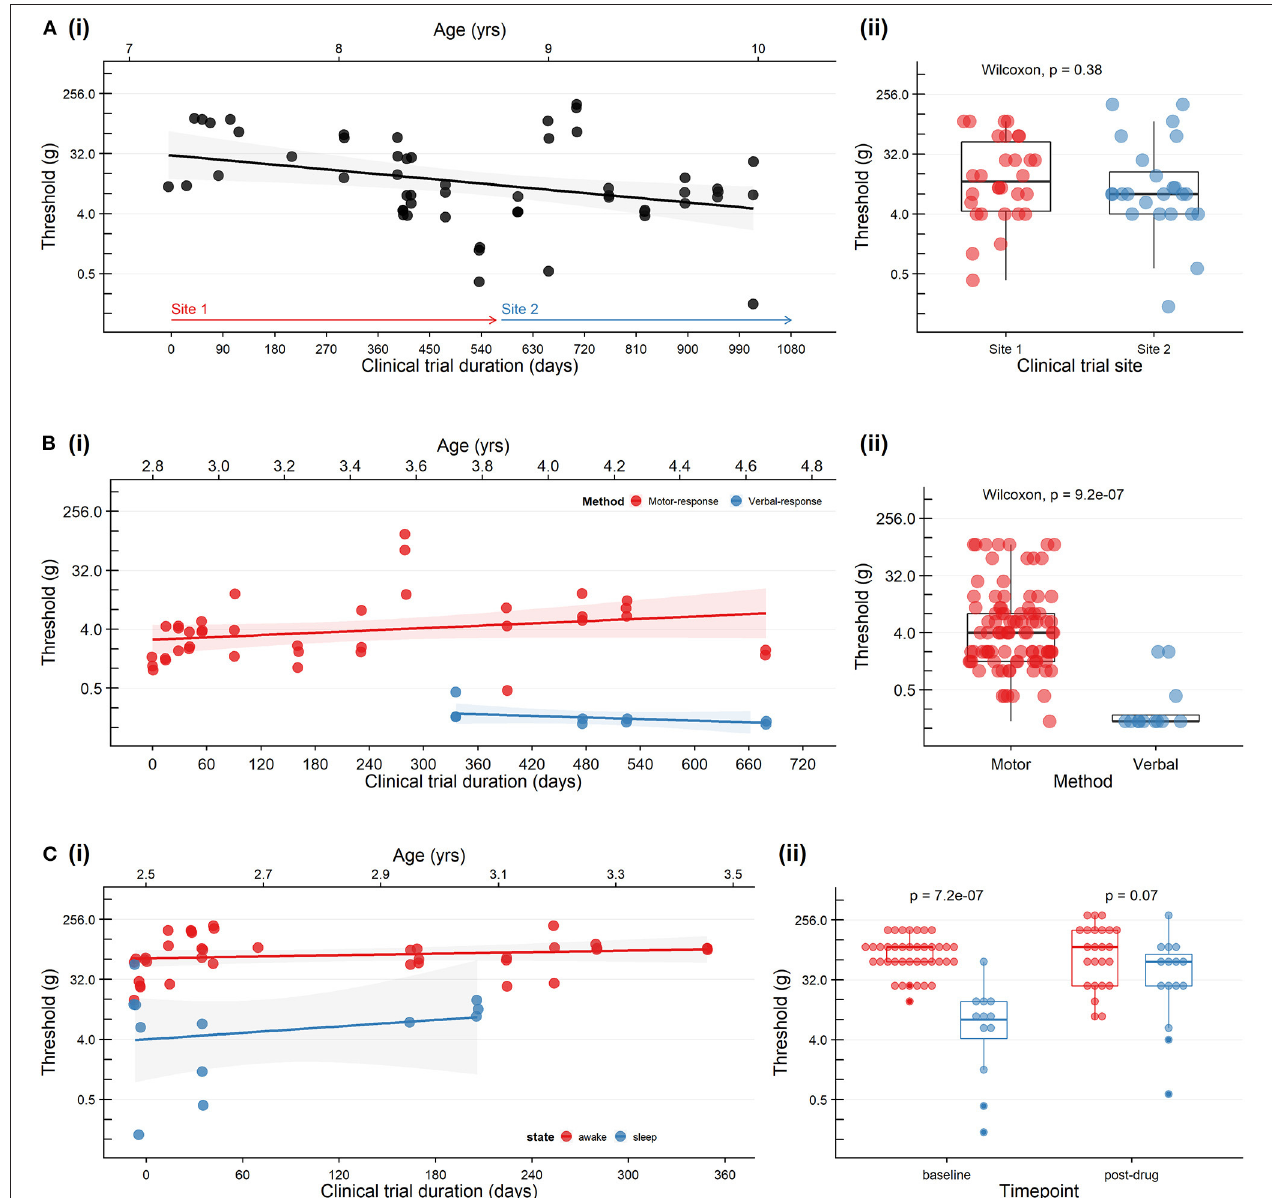
FIGURE 1 | Trends in cutaneous mechanical threshold in three patients with neurodegenerative disorders receiving a personalized investigational intrathecal ASO. (A) A patient with Neuronal Ceroid Lipofuscinosis Type 7 who was studied at two study sites. (i) Baseline sensory thresholds recorded on the day of drug dosing (prior to drug administration). Study site 1 (red arrow) was relocated to a second site (blue arrow) on Day 603. (ii) Baseline sensory threshold data collected at site 1 and site 2 (by site-specific sensory physiologists) showing no clinical or statistically significant differences (Wilcoxon). (B) A patient with Ataxia-Telangiectasia during developmental progression from preverbal to verbal status. Leg flexion withdrawal or feet movement was used consistently over 10 months of the study (motor response: red). At age 3.8 years the patient was able to provide verbal responses as the primary outcome measure (verbal response: blue) and therefore we modifed the protocol to improve engagement and responses. (i) Baseline sensory thresholds recorded on the day of drug dosing (prior to drug administration). (ii) Differences between sensory threshold with verbal and motor responses (Wilcoxon). (C) A patient with Epilepsy of Infancy with Migrating Focal Seizures who exhibited considerable state-dependent variability in the sensory threshold . (i) Baseline sensory thresholds were recorded on the day of drug administration (prior to drug administration) (wakefulness: red; sleep: blue). (ii) Sensory threshold data showing lower sensitivity to mechanical stimulation during wakefulness (red) compared to sleep (blue) at baseline (Wilcoxon). Pre-dose and post-dose sensory thresholds are included in the plot; no statistical difference in pre-drug vs. post-drug sensory thresholds (Wilcoxon, p = 0.53). Sensory thresholds were established by applying von Frey hair monofilaments to the plantar surface of the foot with increasing stimulus intensity. For all plots: each dot represents an individual trial; the scatter plots with a black line and shaded area represent a linear regression fit, and 95% confidence boundaries describing the relationship between time and threshold, and boxplots represent min, max, median, 25 th , and 75 th percentile .